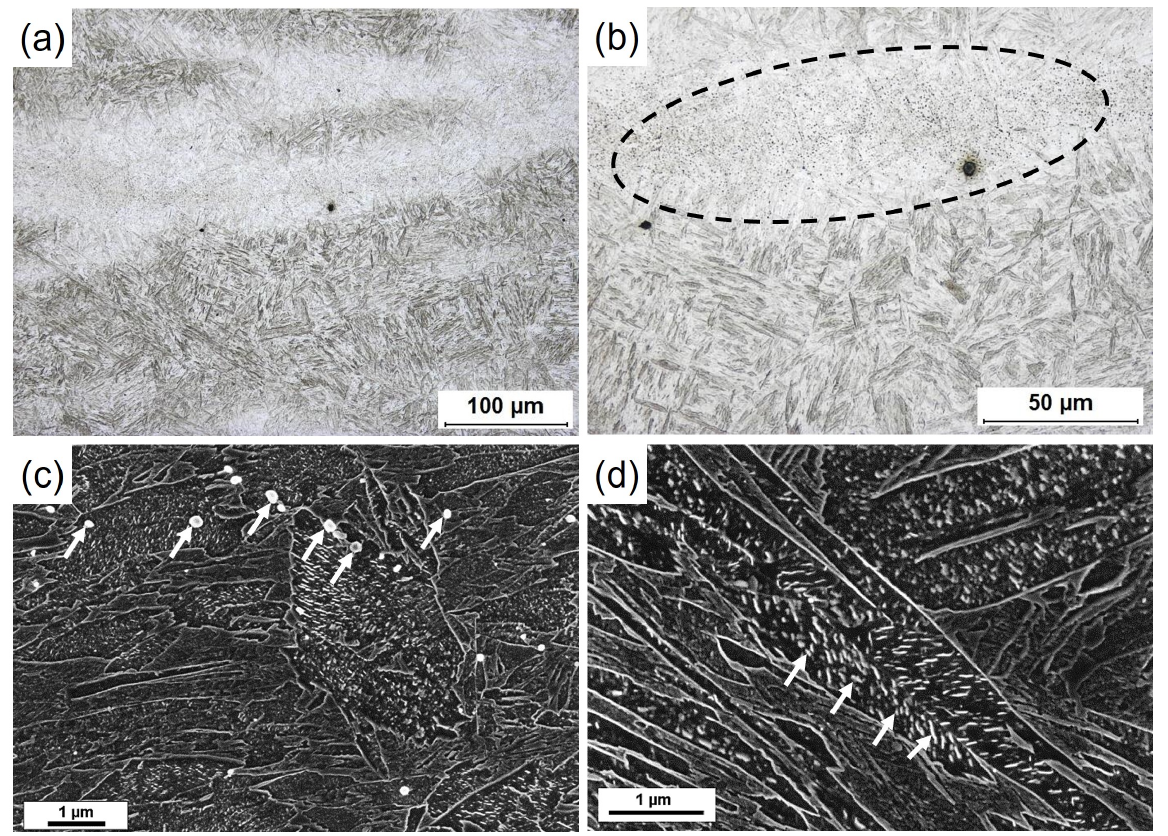
Figure 3. Results by gender for: ( a ) PncSL; ( b ) PST; ( c ) AMS; and ( d ) AS. Figure 4. Micrographs of the AsQ-sample of Material A. ( a ) Overview of AsQ sample taken in optical microscope (OM) showing a segregated microstructure. ( b ) Micrograph showing areas rich (encircled) and poor in primary particles. ( c , d ) Images were taken in scanning electron microscope (SEM) on electropolished surfaces. In ( c ), arrows point at large spherical M 6 C carbides in lath and grain boundaries. In ( d ), arrows point at small rod-like iron carbides seen within the martensitic laths.